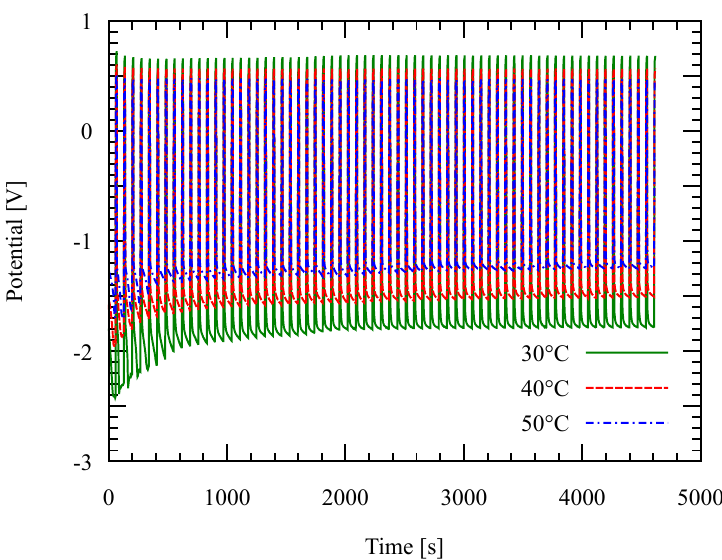
Figure 8. Deposition potential as a function of time during the deposition at different temperatures with a fixed current density of 20 mA/cm 2 . Negative potential shows the deposition